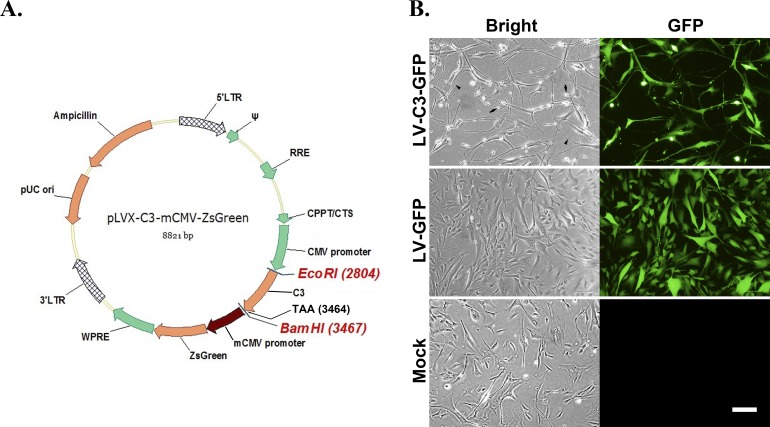
Morphology of cultured HTM cells after transduction with lentivirus vectors. (A) Lentiviral construct. (B) Cells in 24-well plate transduced with LV-C3-GFP and LV-GFP, respectively, both at MOI of 400. The LV-C3-GFP–transduced cells appeared to be either rounded up (arrows) or elongated (arrowheads) for at least 144 hours (end of observation) when compared to LV-GFP–transduced cells and medium-only–treated control (mock). Scale bar: 100 μm. CMV, cytomegalovirus promoter; CPPT/CTS, central polypurine tract/central termination sequence element; C3, exoenzyme C3 transferase; LTR, 5′ long terminal repeat; mCMV, murine cytomegalovirus promoter; RRE, reverse response element; TAA, termination codon; WPRE, woodchuck hepatitis virus posttranscriptional regulatory element; ZsGreen, Zoanthus sp. green fluorescent protein; ψ, packaging signal.